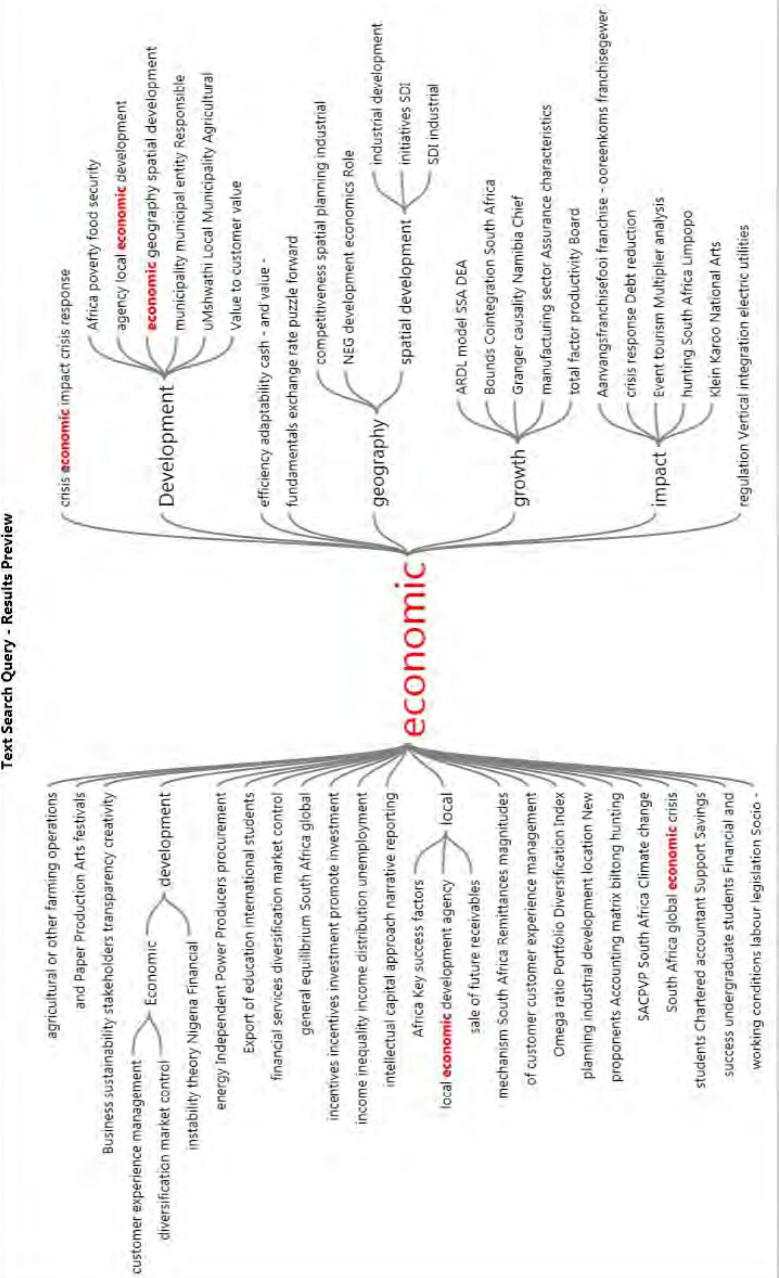
FIGURE 5: Word Tree Diagram: ‘Economic’